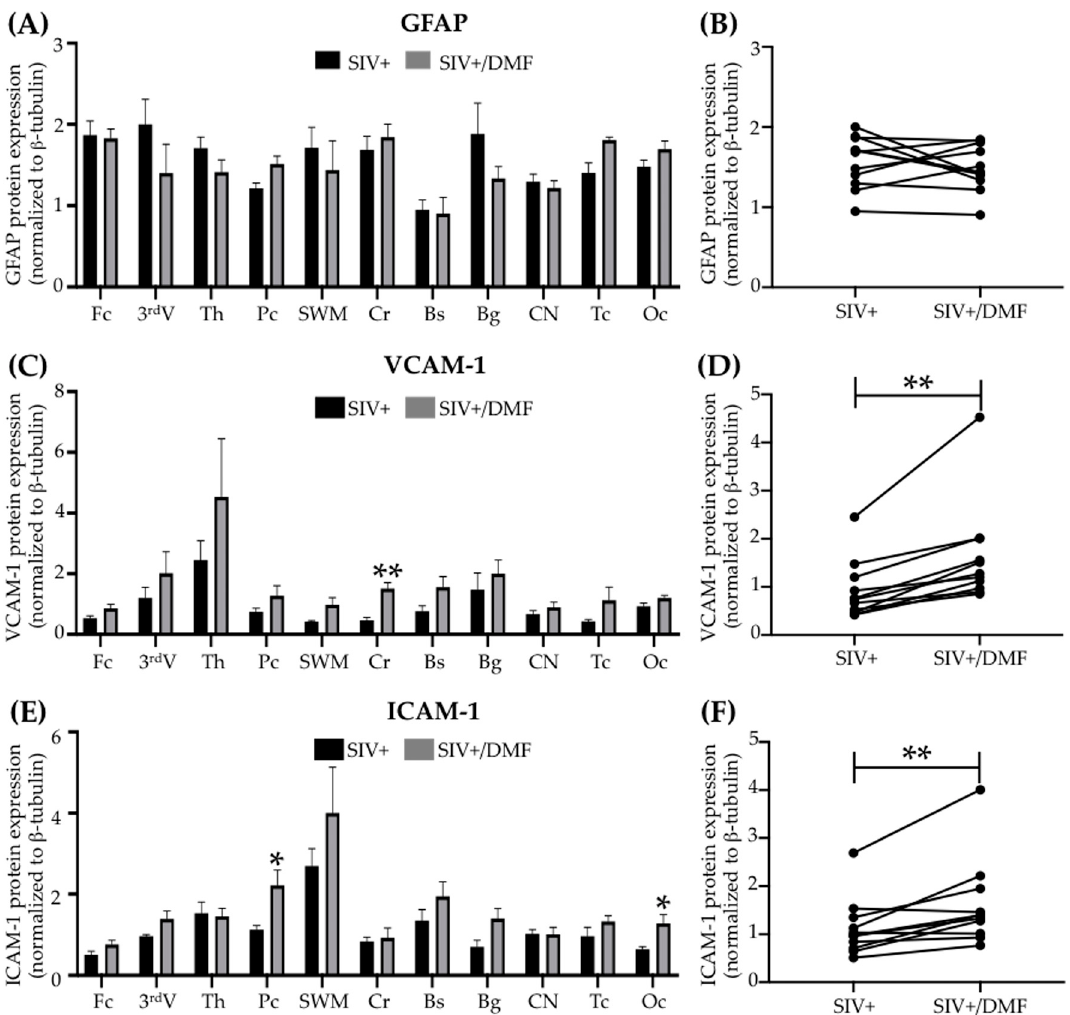
Figure 12 . DMF treatment was associated with higher VCAM-1 and ICAM-1 expression in the brains of SIV-infected macaques. ( A , B ) No significant differences in the GFAP expression were observed in individual regions or overall in the brains with DMF treatment. ( C ) A significant increase in VCAM-1 expression in the cerebellum (Student’s unpaired t -test, ** p < 0.01) and in the overall mean expression ( D ) with DMF treatment (Student’s paired t -test, ** p < 0.01). ( E ) A significant increase in the ICAM-1 expression in the parietal and occipital cortexes (Student’s unpaired t -test, * p < 0.05) and in the overall mean expression ( F ) with DMF treatment (Student’s paired t -test, ** p < 0.01). Eleven brain regions from 9 SIV-infected rhesus macaques (4 untreated animals and 5 DMF-treated (90 mg total DMF daily)) were analyzed using Western blotting. In the right panels, each dot represents the mean expression of one brain region from all animals in the group. Fc: frontal cortex, 3 rd V: third ventricle, Th: thalamus, Pc: parietal cortex, SWM: subcortical white matter, Cr: cerebellum, Bs: brainstem, Bg: basal ganglia, CN: caudate nuclei, Tc: temporal cortex, Oc: occipital cortex. All values are expressed as mean ± SEM.